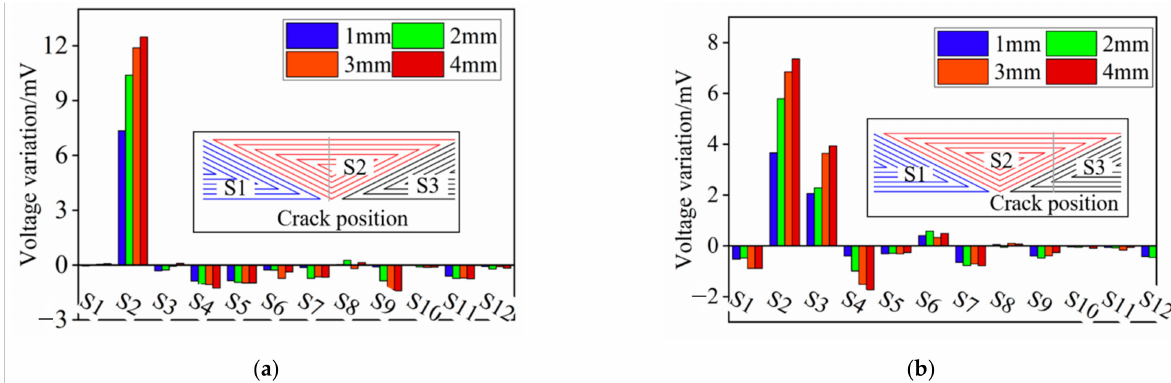
Figure 17. Experimental results when the crack grows in the radial direction at two circumferential positions. ( a ) Voltage variation when the crack position is at the middle of the S2; ( b ) voltage variation when the crack position is in the middle of the S2 and